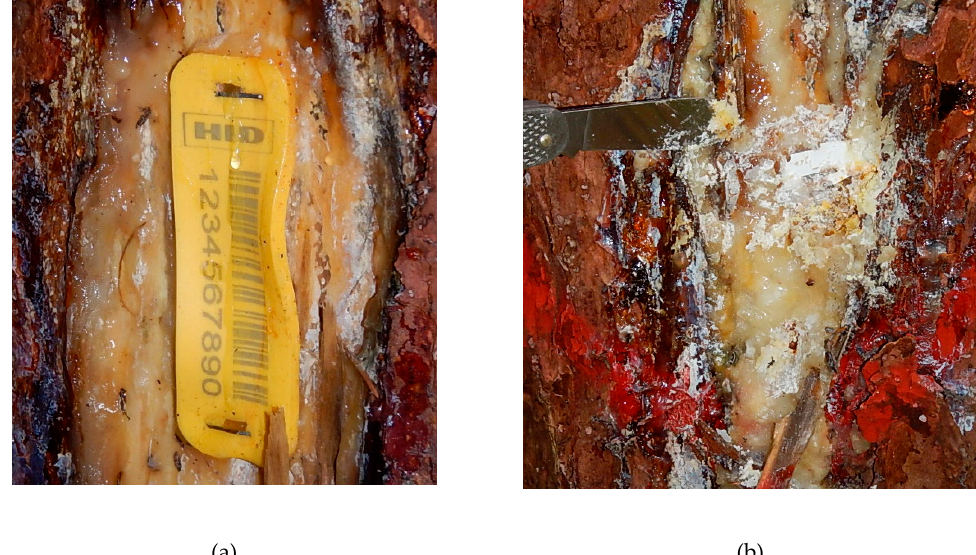
Figure 5. ( a ) HS model and ( b ) CP model after 2 years. Note how the first has bent due to tree growth and the latter is covered by resin.